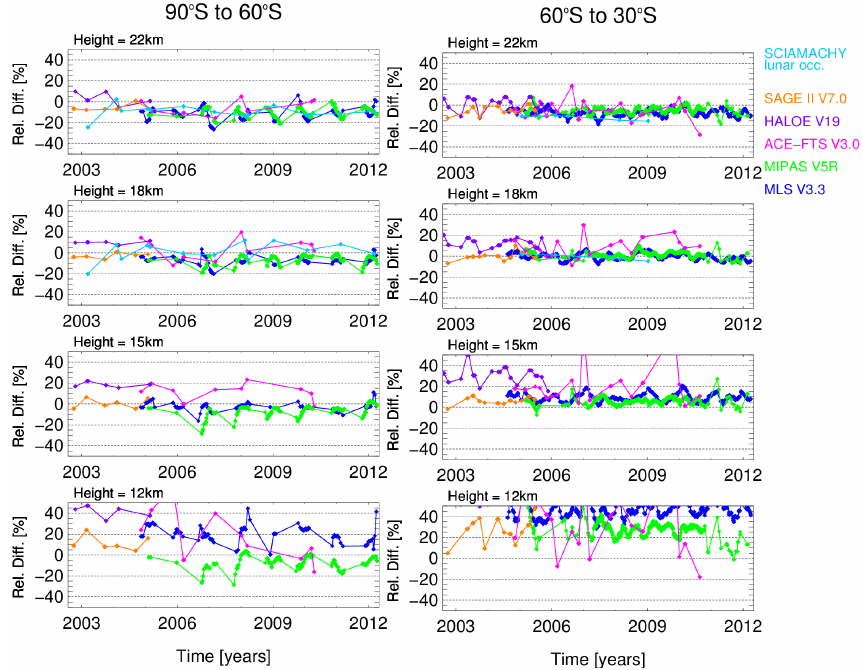
Figure 18. Like Fig. 17 for polar (left panels) and middle latitude regions (right panels) in the SH.